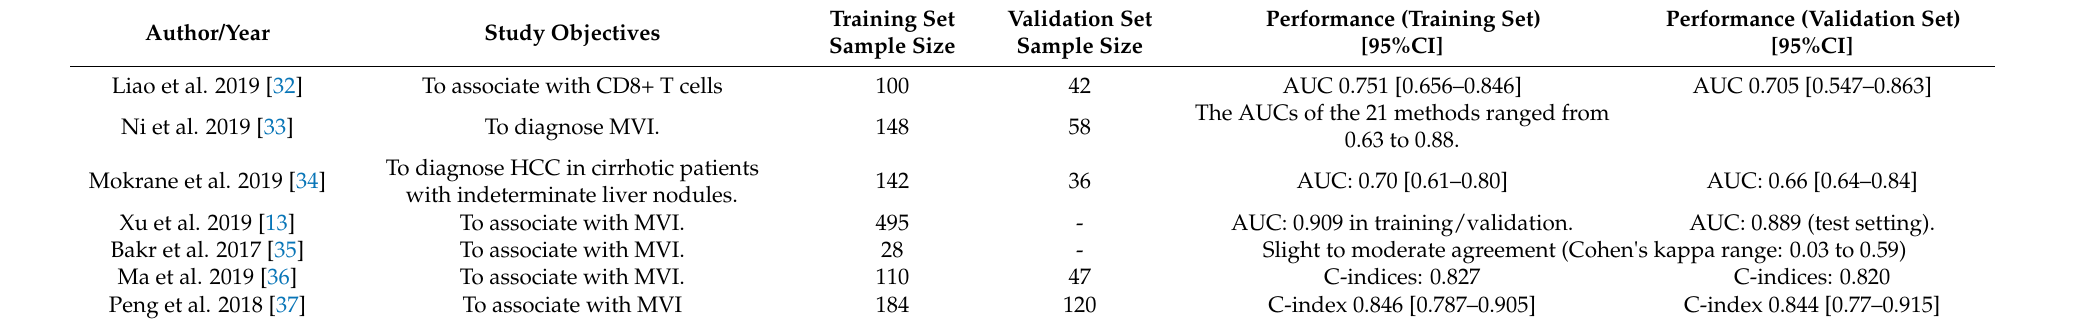
Table 4. Performance of radiomics approaches (CT underlying pathology).